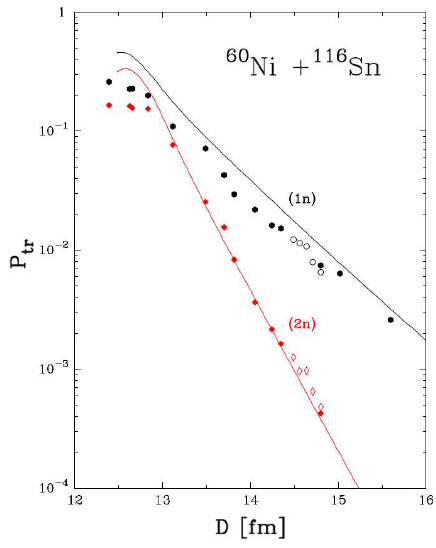
Figure 6. Experimental (points) and microscopically calculated (lines) transfer probabilities ( P tr ) as a function of the distance of closest approach ( D ) for one- ( 61 Ni) and two-neutron ( 62 Ni) transfers in the 60 Ni + 116 Sn system. Open symbols correspond to the probabilities obtained from angular distribution in direct kinematics [38] while solid symbols refer to the excitation func- tion measurement performed in inverse kinematics